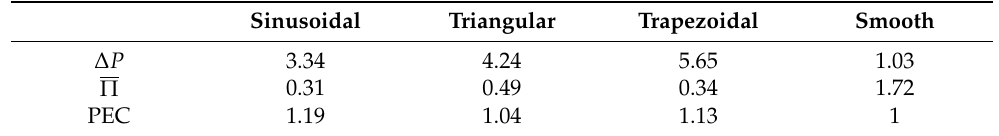
Table 5. The dimensionless pressure drop of the test section and the dimensionless mean apparent viscosity of the cross section at the outlet of the test section of the corrugated and smooth channels and thermal performance evaluation